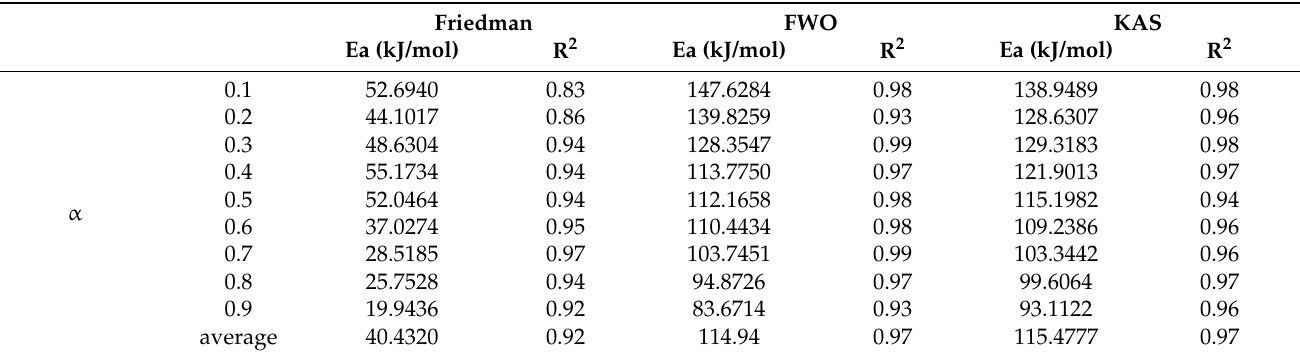
Table 2. Ea and R 2 of three model-free methods at different conversion rates in the second stage of pyrolysis kinetics of battery materials.